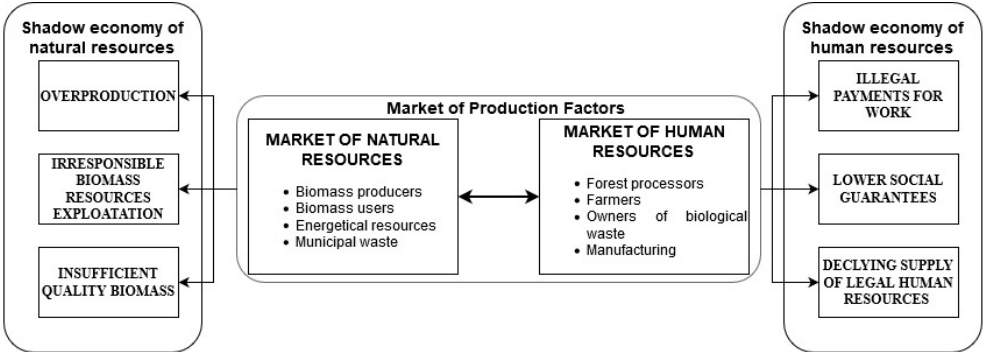
Figure 1. The impact of the shadow economy on the market of production factors from a regional perspective.